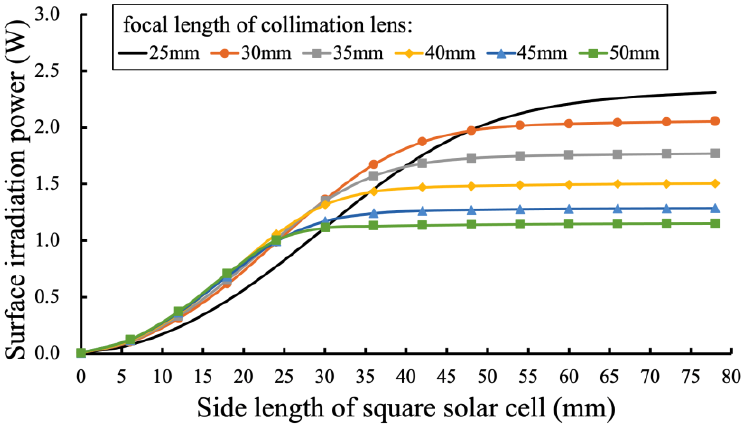
Figure 5. Simulated irradiation power at 1 m with different focal lengths of collimation lenses.